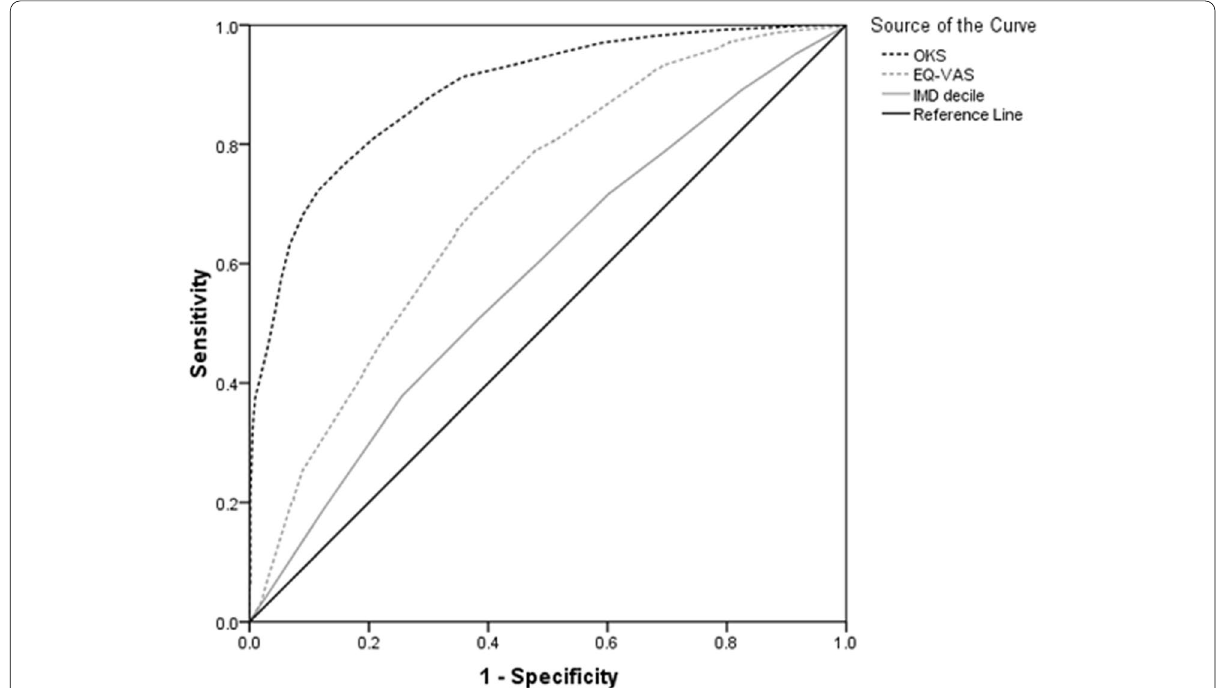
Fig. 2 Receiver operating characteristic curves for OKS, EQ-VAS and indices of multiple deprivation as predictors of a health state